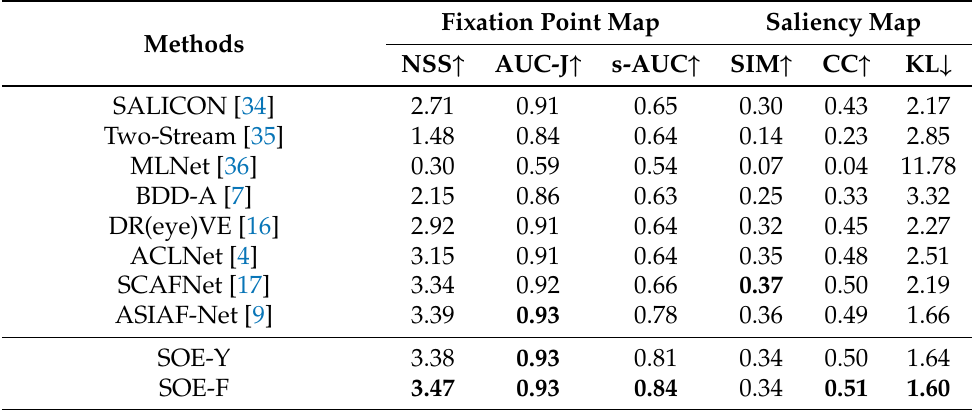
Table 1. Comparison of the saliency metrics of SOE-Y and SOE-F with those of the other state-of-the- art methods on the DADA-2000 test set (The symbol ↑ prefers a larger value and ↓ expects a smaller value. Bold indicates the best